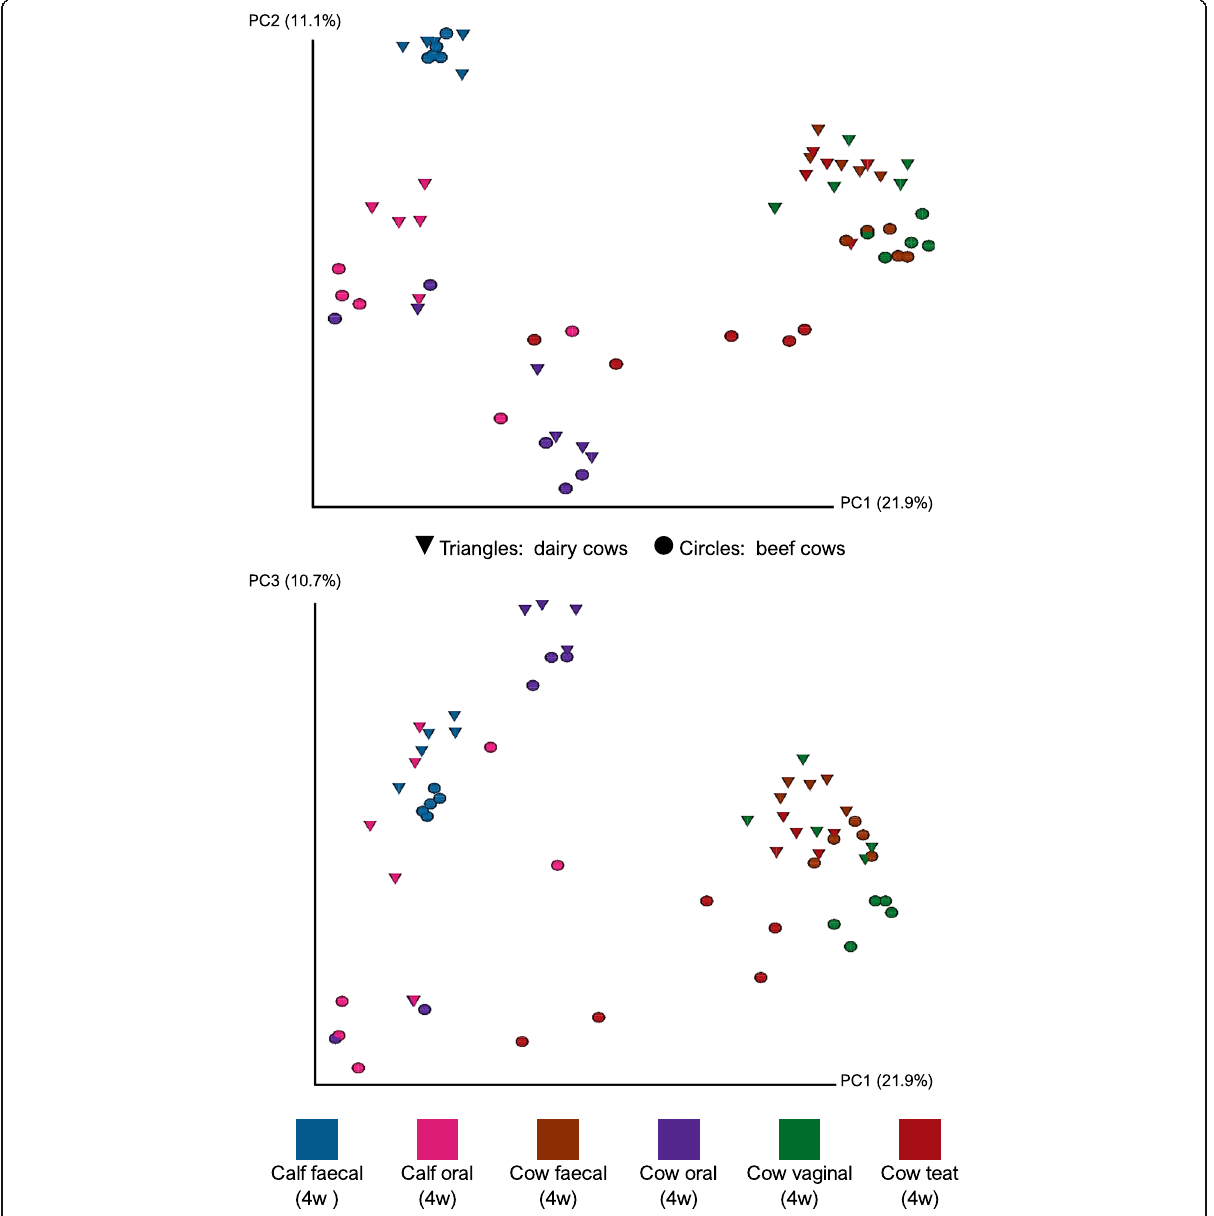
Fig. 4 Principal Coordinate Analysis (PCoA) of unweighted UniFrac distances at the four-weeks. Beef animals are represented by circles and dairy animals by triangles. The four-week timepoint is 4 weeks after parturition. The two plots display the same data but with different y-axes to display the three-dimensional relationship between datapoints. The number of individual animals in each group: N =